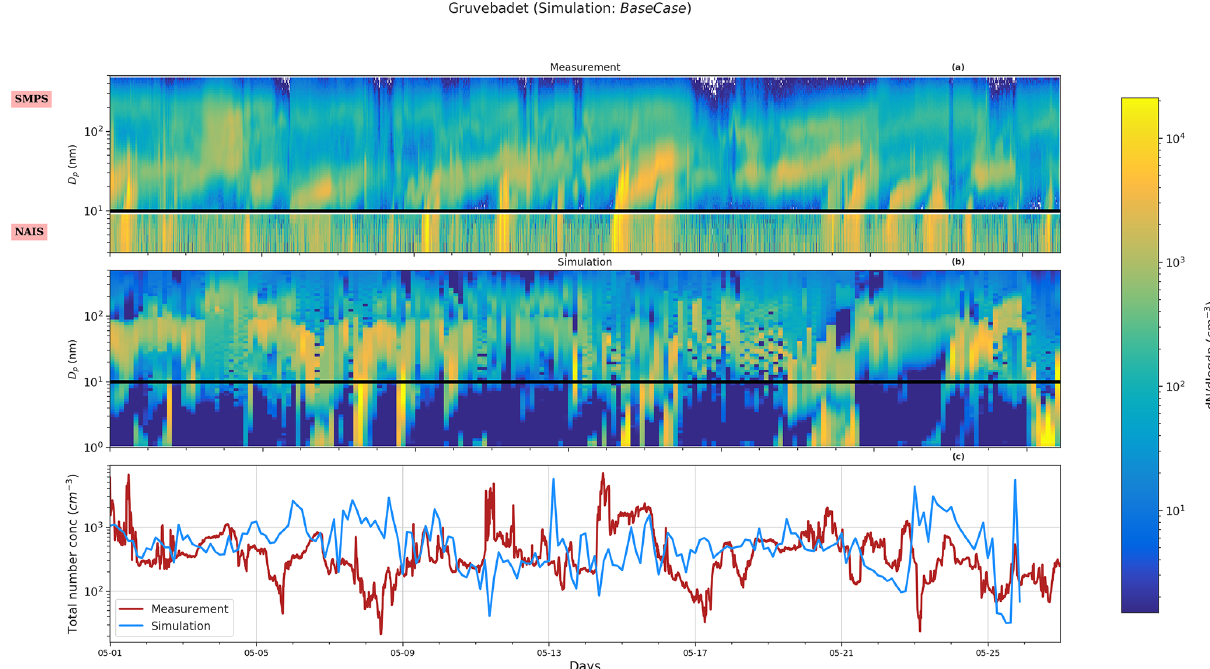
Figure 1. Particle number size distribution at Gruvebadet for BaseCase. Panel (a) shows the measurement data for the period 1–25 May from SMPS (10–470nm) and NAIS (2.5–10nm), panel (b) provides the modeled particle size distribution, and panel (c) shows the total measured and simulated number concentrations. The black line at 10nm denotes the boundary above which SMPS data start and NAIS data end. The abscissa indicates the time for the entire simulated duration. The ordinate in Fig. 1 for both panels (a) and (b) indicates the particle diameter ( D p ,